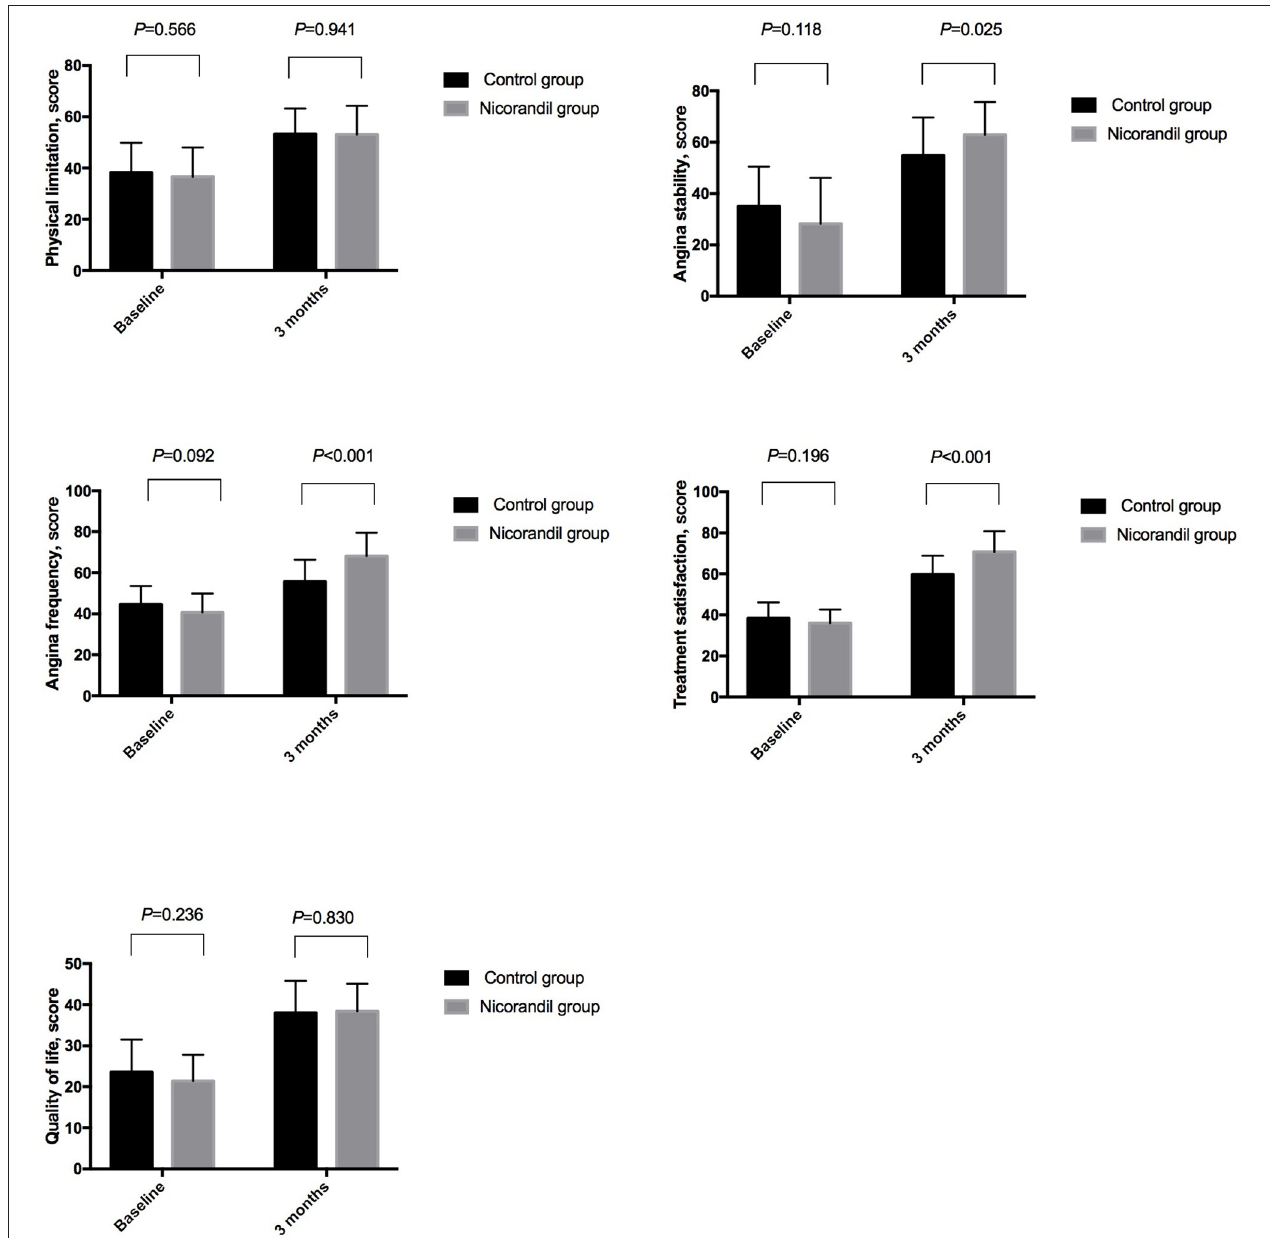
FIGURE 3 | Comparison of seattle angina questionnaire scores between the nicorandil group and the control